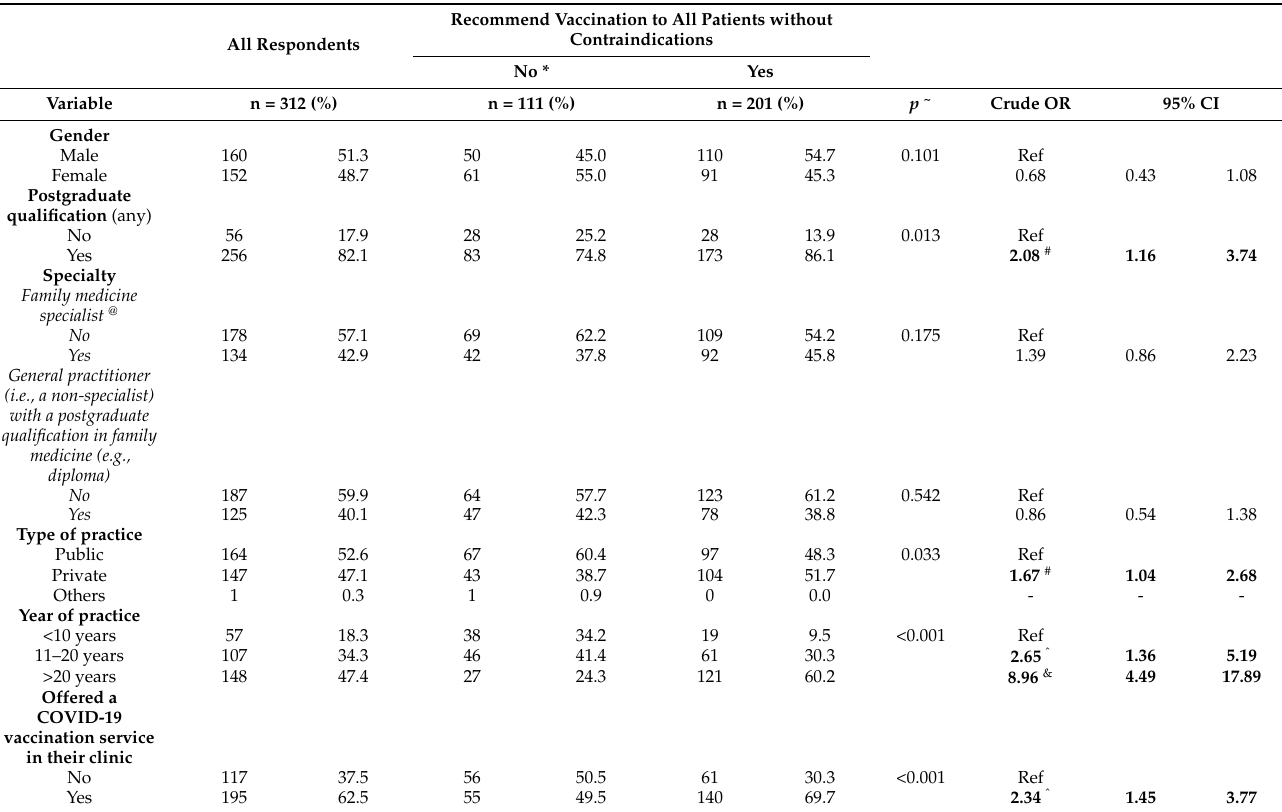
Table 1. Descriptive statistics of demographic and practice-related characteristics of family doctors and their association with making COVID-19 vaccination recommendations (N =